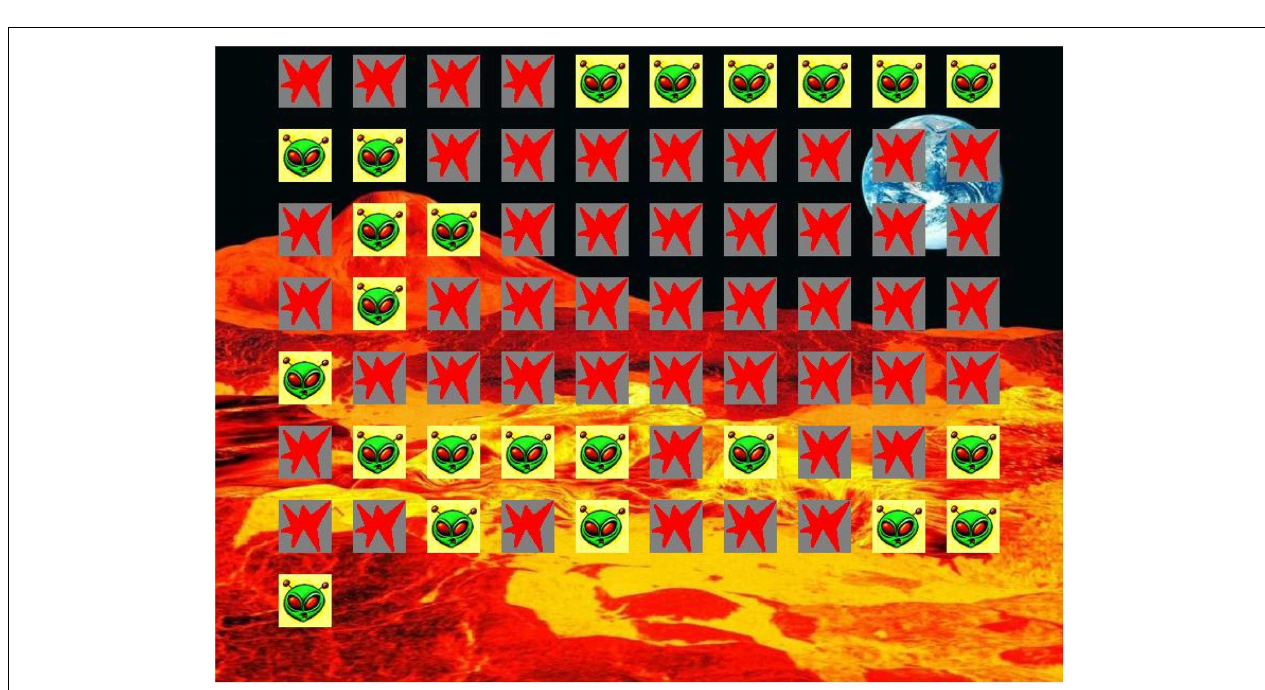
FIGURE 1 | Screenshot from the Martians preparation . Depicted are Martians and explosions (when Martian is shot by pressing the space bar) against a CS-background picture of a space